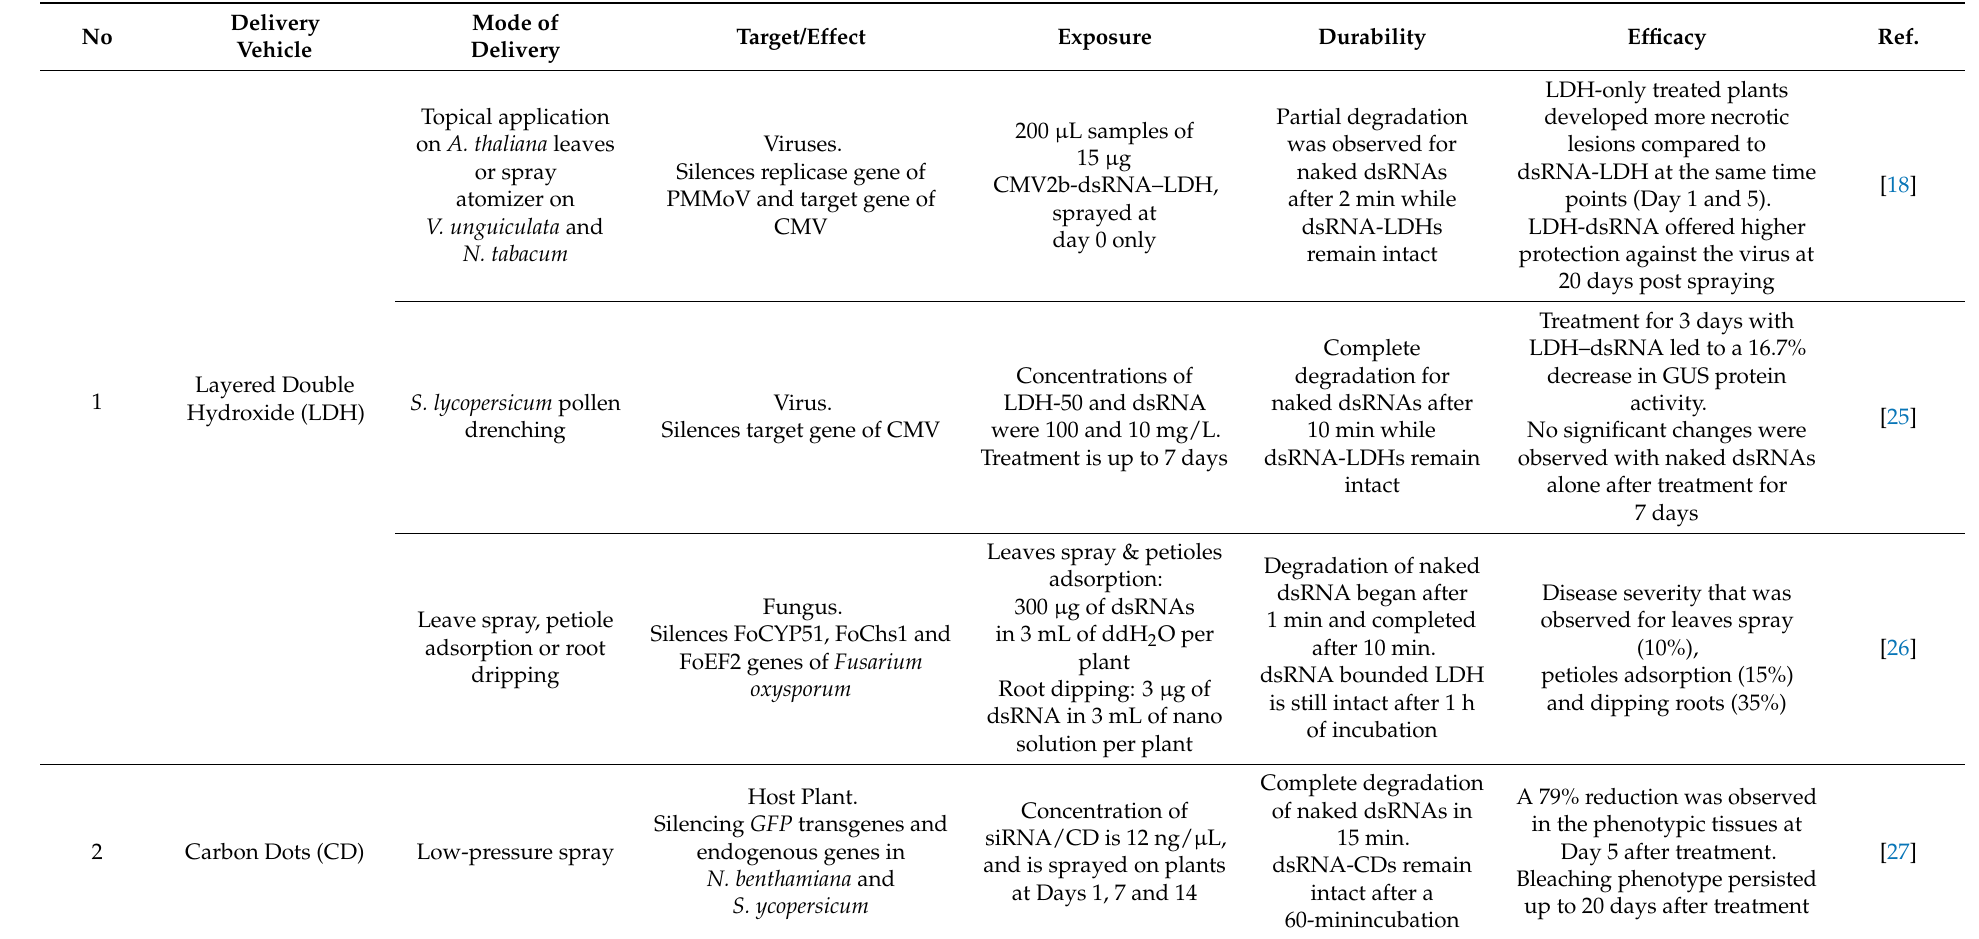
Table 2. Summary of mode of delivery for RNAs, its targets or desired